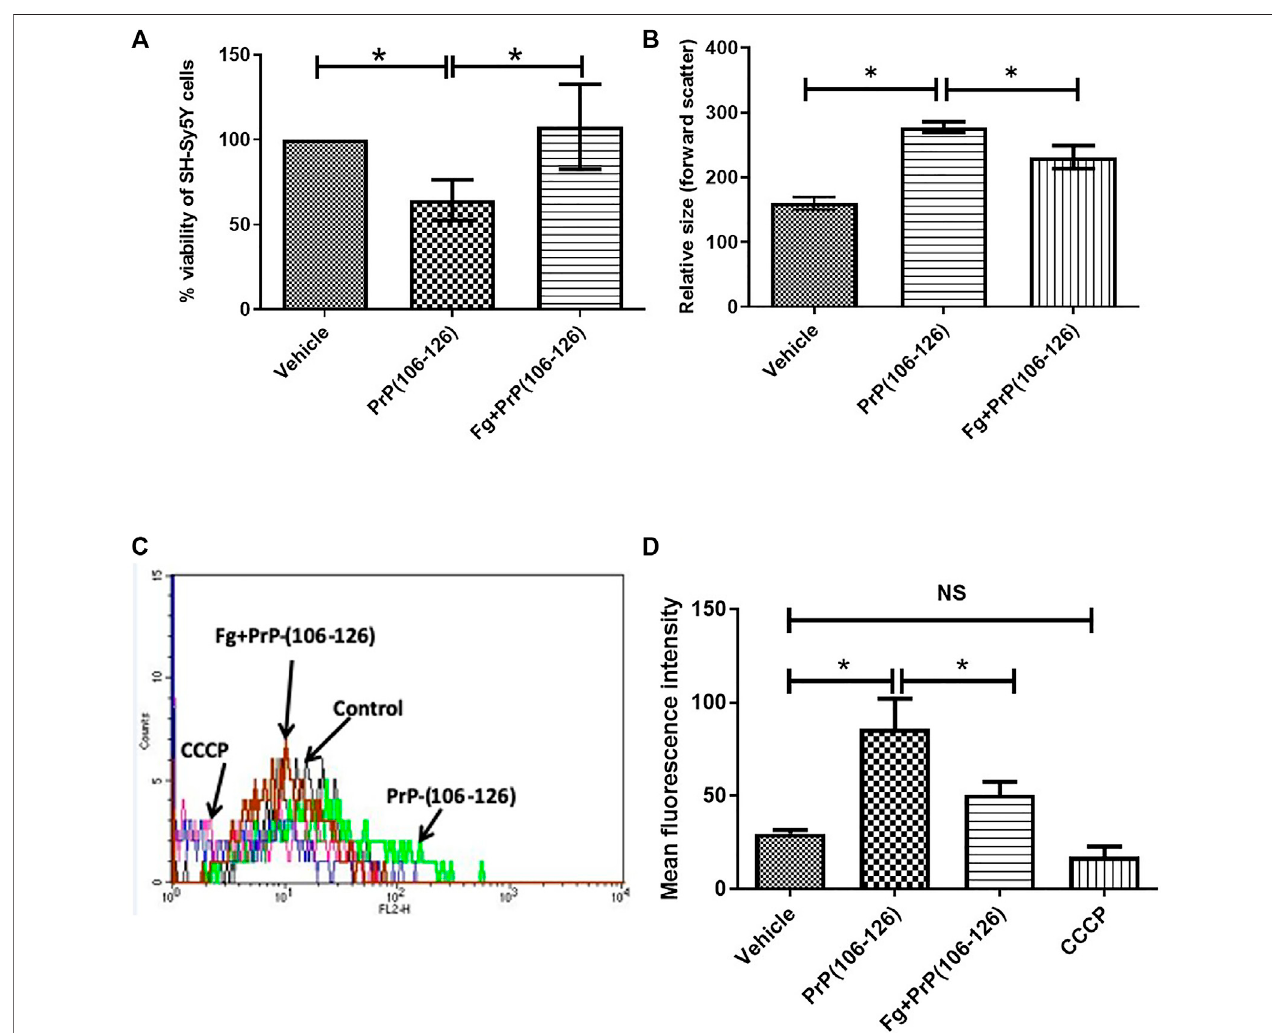
FIGURE 3 | Fibrinogen prevented toxicity of prion peptide on SH-SY5Y neuronal cells. (A) Measurement of viability of SH-SY5Y cells by MTT assay following PrP treatment in the presence or absence of fi brinogen. (B) Flow cytometry of neuronal cells treated with PrP(106 – 126) in the presence or absence of fi brinogen. (C,D) Measurement of mitochondrial transmembrane potential by MitoTracker Red staining in prion peptide-treated SH-SY5Y neuronal cells in absence or presence of fi brinogen. Figures are representative of ≥ 3 independent experiments (mean ± SEM, p < 0.05).